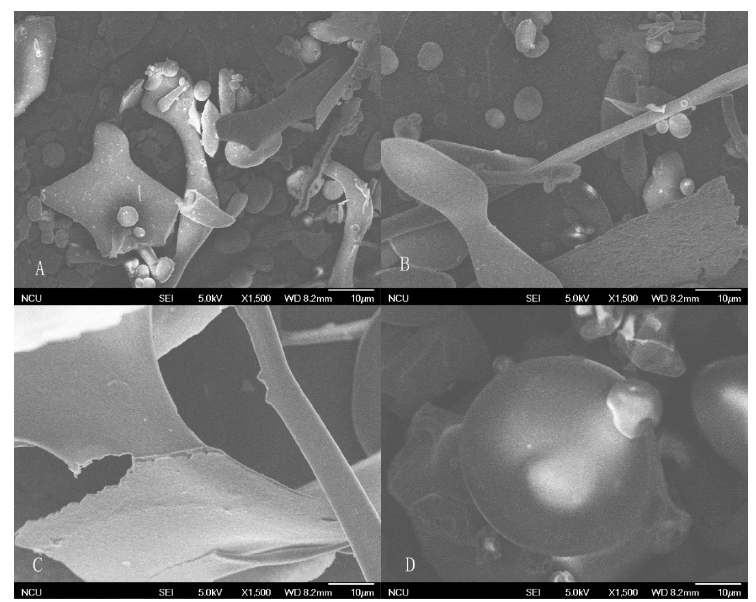
Figure 3. The SEM images of cashew nut albumin ( A ); globulin ( B ); glutelin ( C ) and CNPI ( D ).